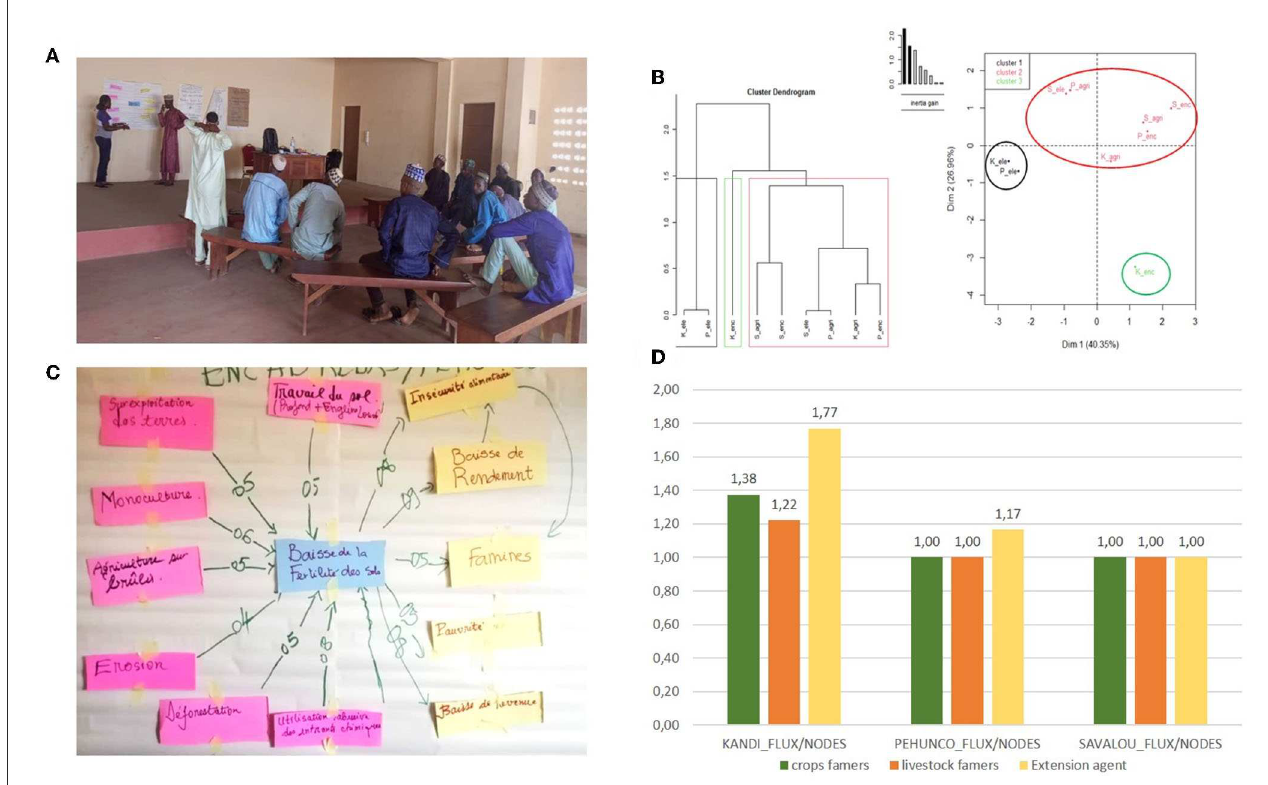
FIGURE2 (A) Picture taken during the participatory workshops with farmers; (B) Picture of a fuzzy-cognitive map representing farmers’ perceptions on the processes that lead to soil fertility decline (number on each arrow indicates the relative importance of each driver); (C) Hierarchical bottom-up classification of producers and supervisors in the different zones according to their perceptions of soil fertility decline factors; (D) Degree of complexity of the perception of the different actors as measured by the ratio of interactions per concept (flows to nodes, or arrows to boxes